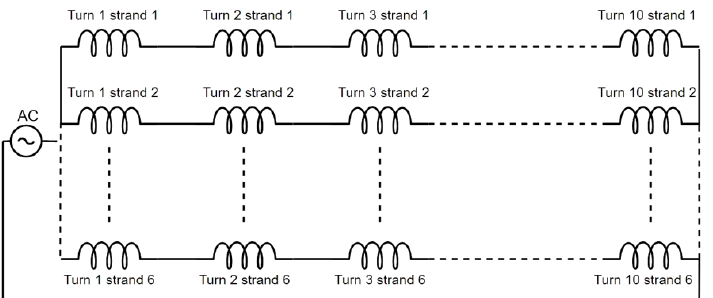
Figure 12. The configuration of strands and bundles in the slot as: ( Left ) horizontal (ARR1); ( Centre ) vertical bundled (ARR2); ( Right ) horizontal bundled (ARR3).